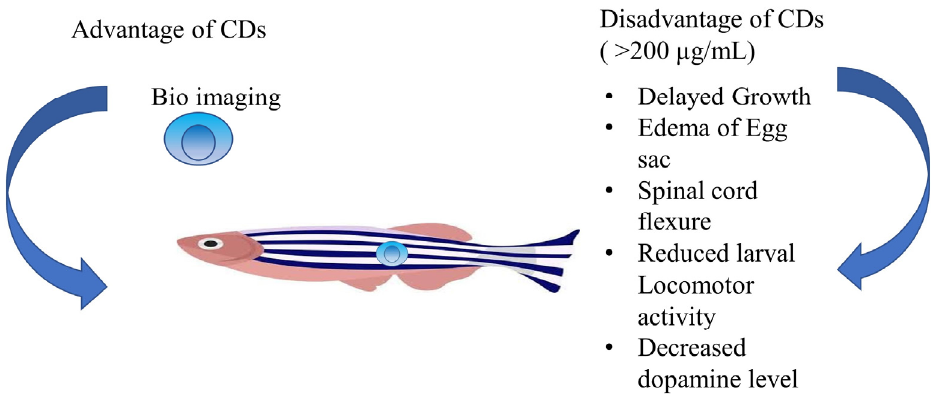
Figure 3. Overview of advantage and disadvantage of CDs in Zebra fish model [122].